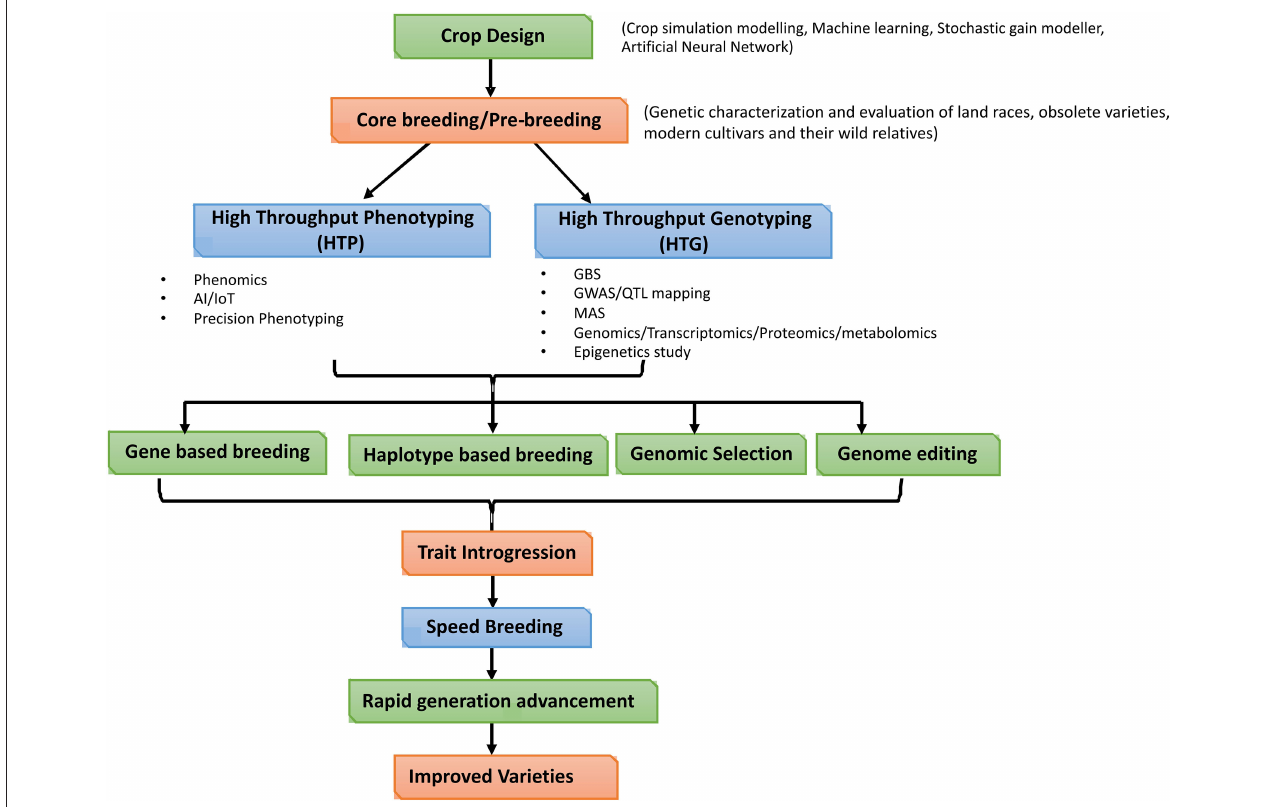
FIGURE 4 | A hypothetical integrated fast forward breeding pipeline AI: artificial intelligence, IoT: internet of things, GBS: genotyping by sequencing, GWAS: genome wide association study, QTL: quantitative trait loci.